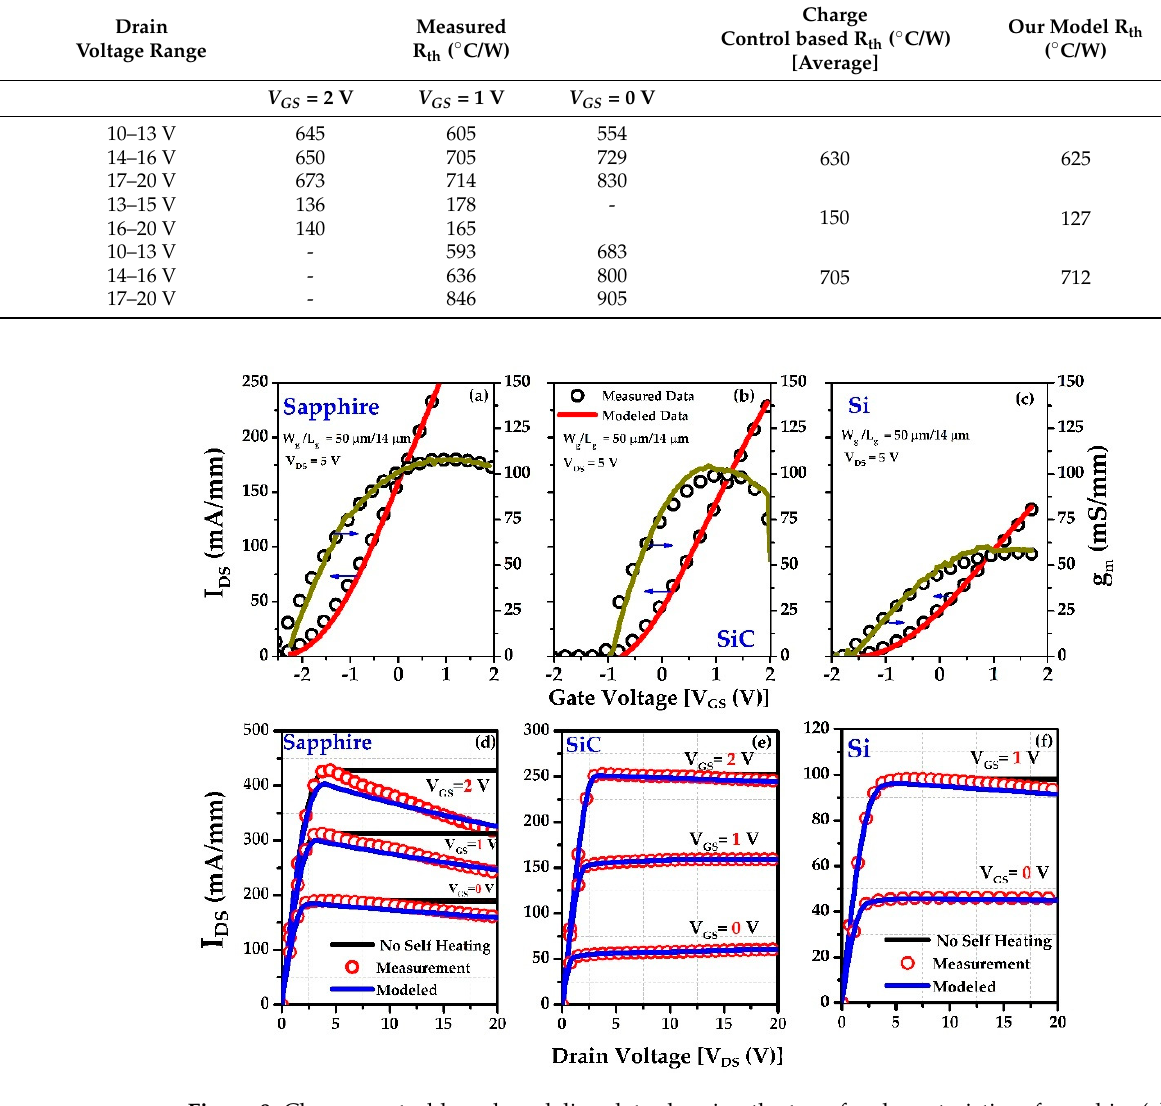
Figure 8. Charge control-based modeling data showing the transfer characteristics of sapphire ( a ), SiC ( b ), and Si ( c ). Modeled output characteristics and measurement data of sapphire ( d ), SiC ( e ), and Si ( f ).